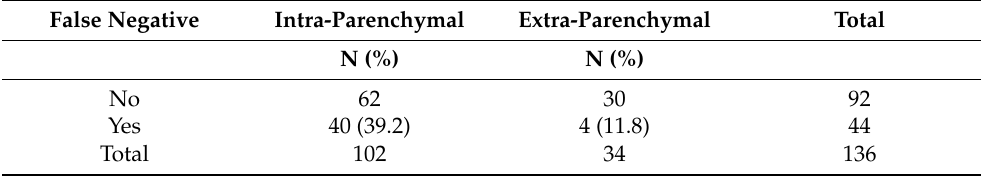
Table 8. Influence of the cyst localization on the results of the first serological Ring